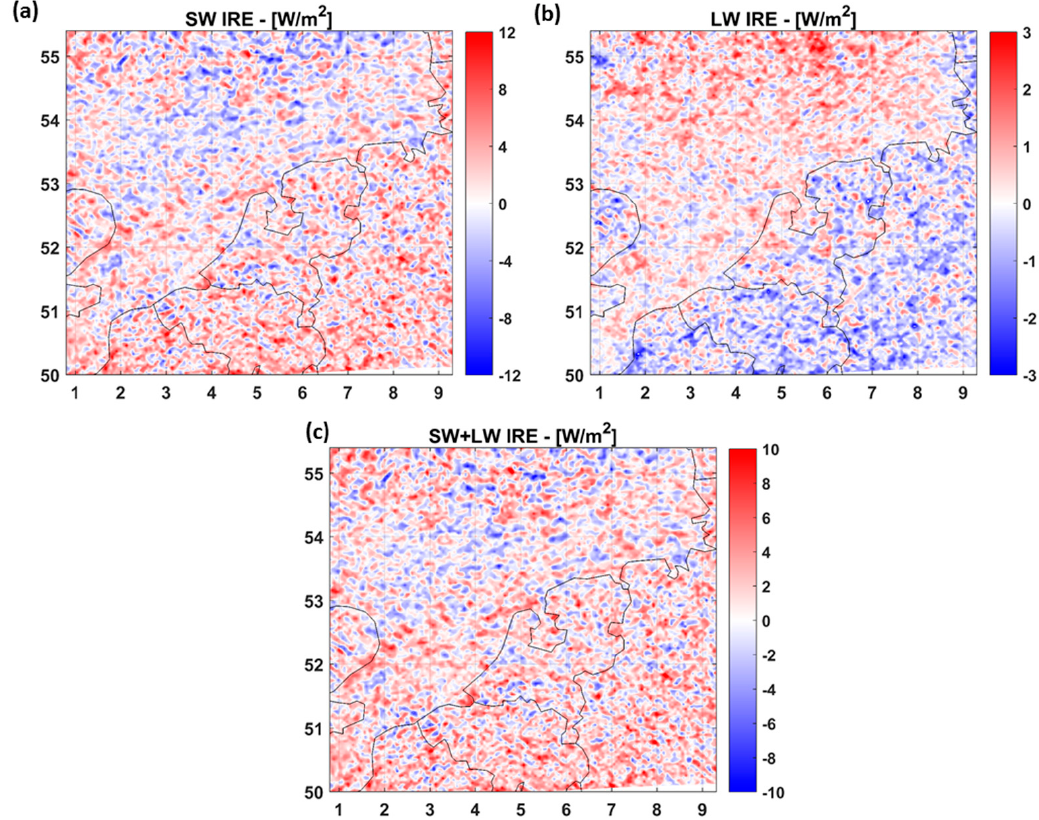
Figure 12. Indirect radiative effect (IRE) exerted by halving of emissions on ( a ) visible radiation, ( b ) longwave radiation and ( c ) total radiation.